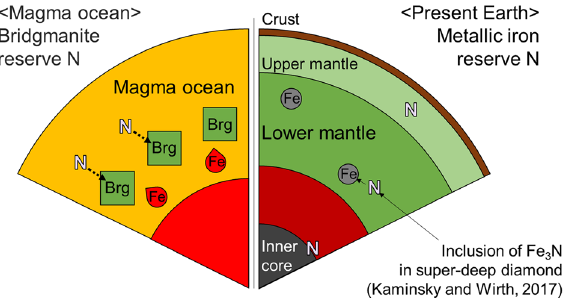
Figure 6. Schematic depicting the nitrogen reservoir formation processes in the lower mantle through solidification of the terrestrial magma